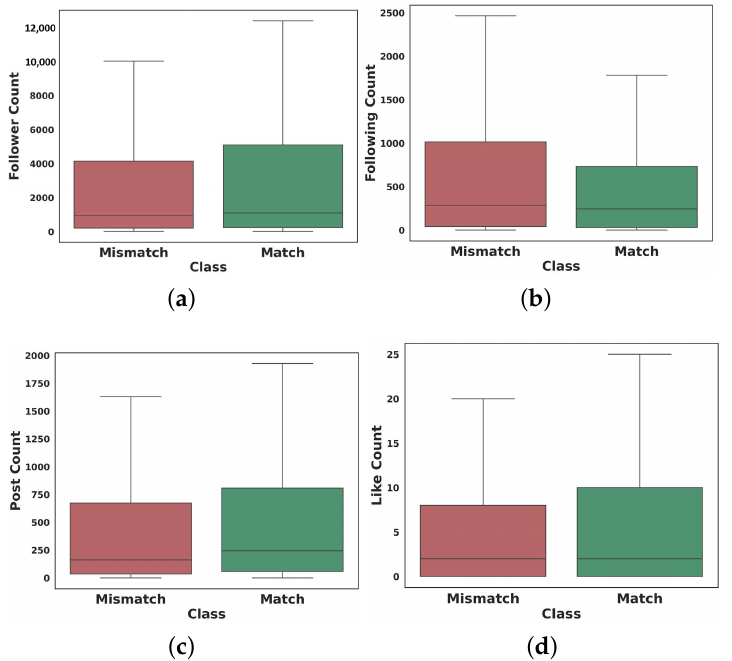
Figure 9. User engagements in the match and mismatch content (the outliers are ignored), ( a ) Follower count, ( b ) Following count, ( c ) Post count, and ( d ) Like